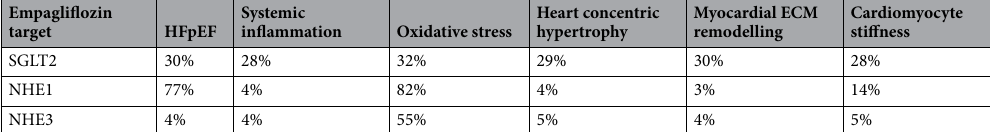
Table 1. Efficacy of empagliflozin on individual targets in HFpEF. Columns show the artificial neural networks (ANN) score obtained (in %) for each target in HFpEF (as a whole) and in each